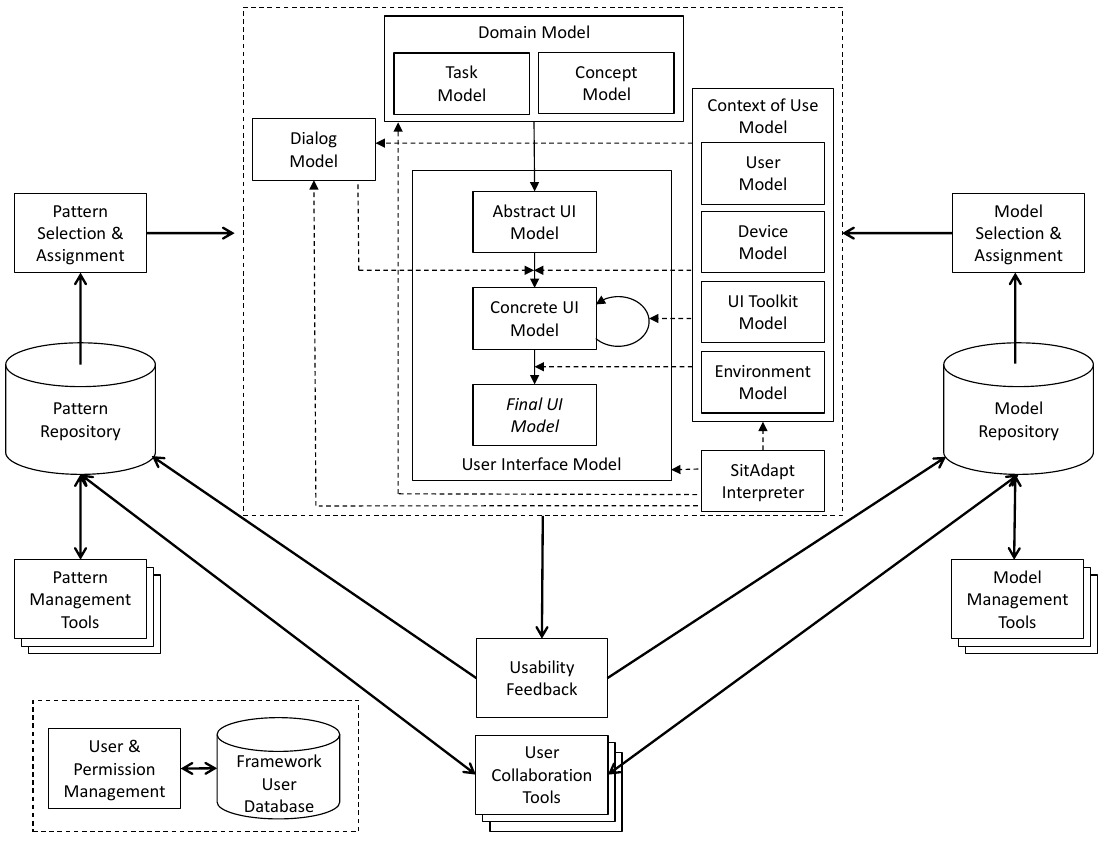
Figure 4. PaMGIS MBUID framework with SitAdapt Interpreter and communication flow for CRF- model interaction [10]. The situation analytics component resides in the SitAdapt Interpreter. Adaptations triggered by the situation analytics component may involve the pattern and model resources of the PaMGIS